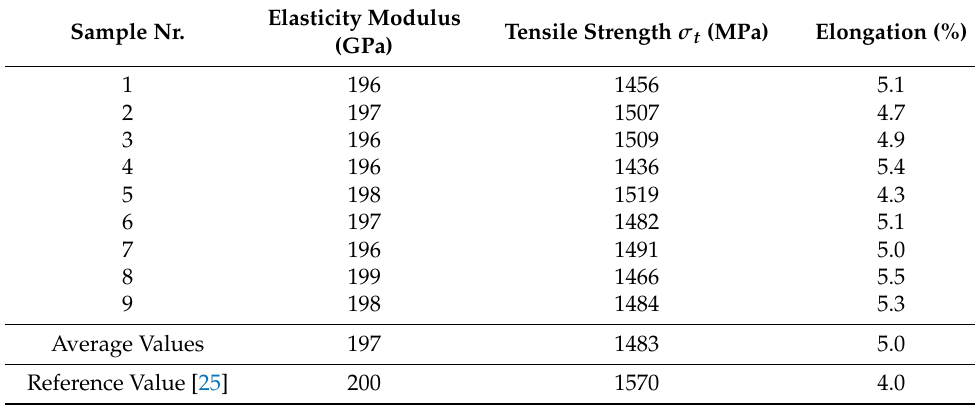
Figure 9. Subsurface corrosion damage on visually uncorroded surface. 2.2. Finite Element Analysis In order to determine the remaining strength of the damaged wire, numerical mod- eling was performed under static and dynamic loading — simulating the size of previously measured damages according to the data obtained from the materials in use. As the